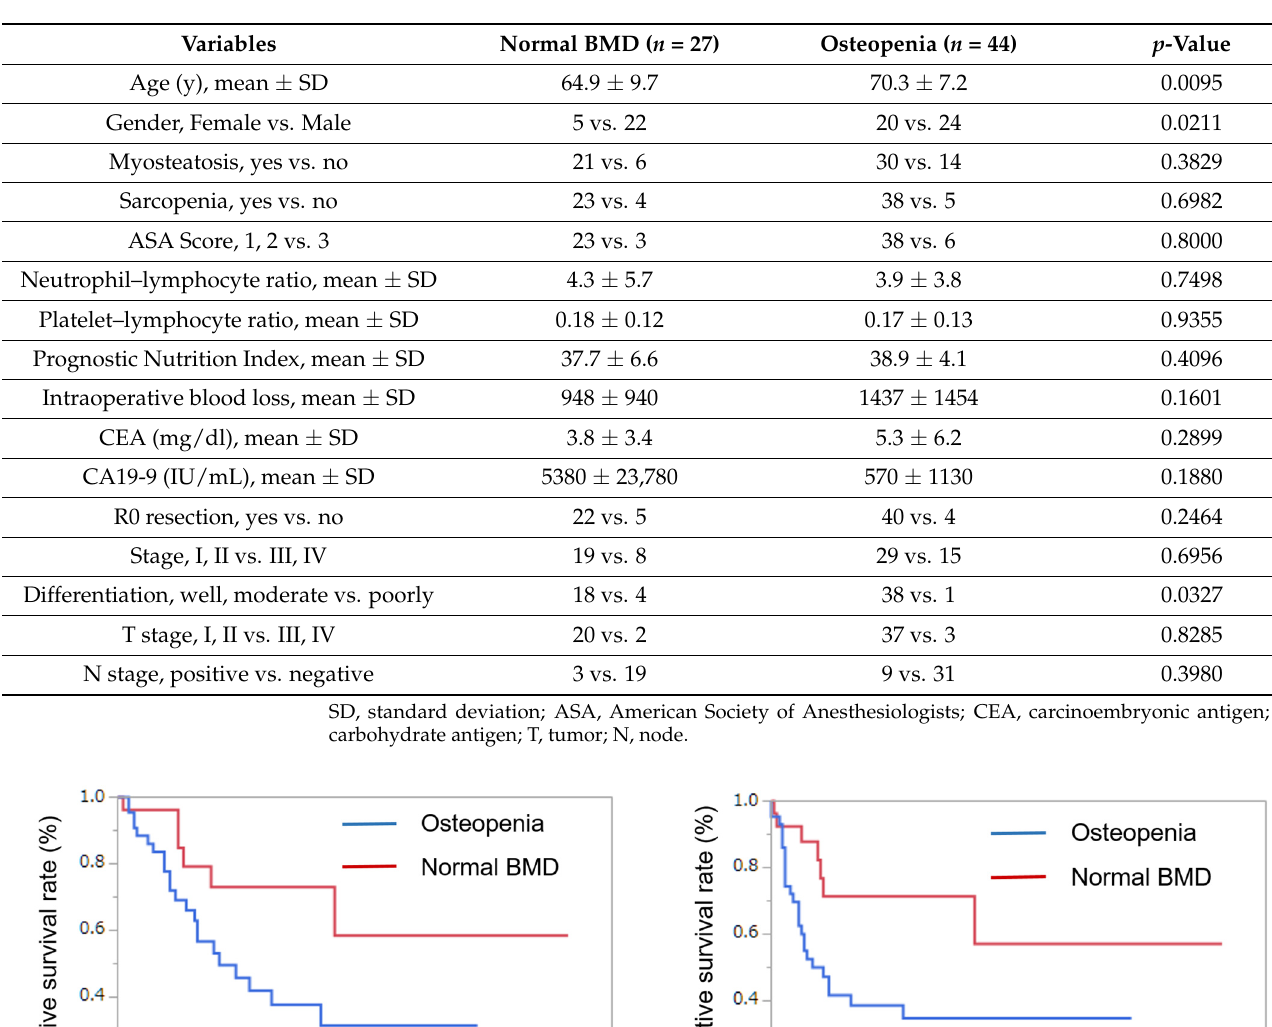
Table 1. Clinicopathological characteristics of patients.